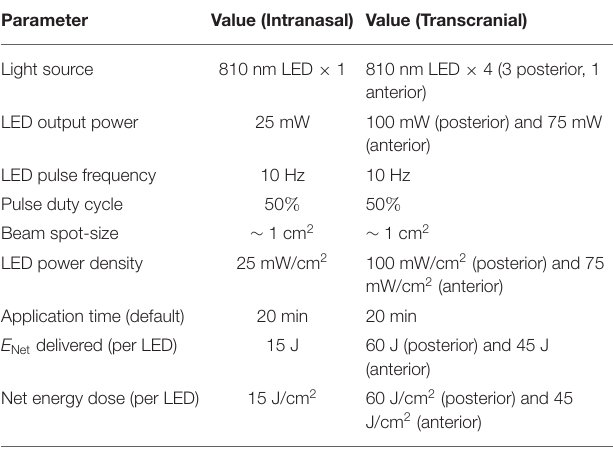
TABLE 1 | Vielight Neuro Alpha parameters.